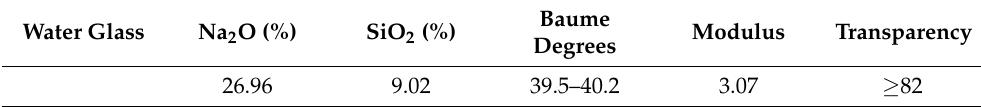
Table 2. Physical and chemical indices of water glass.